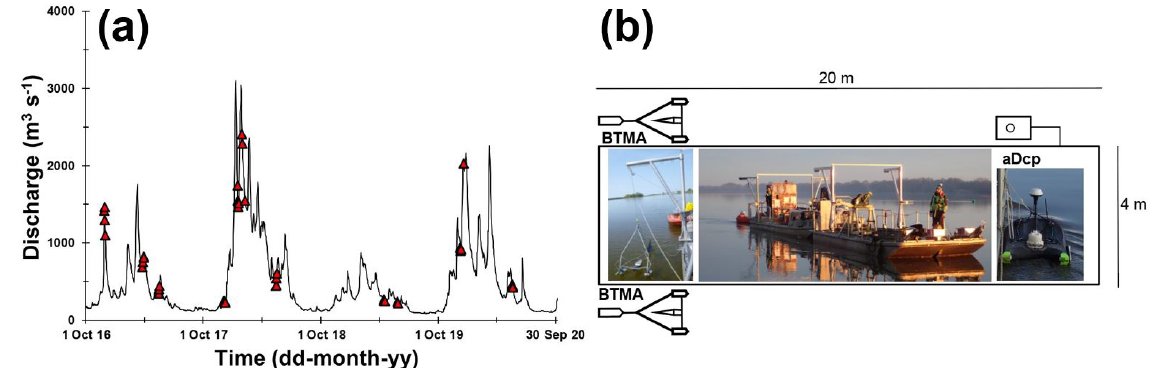
Figure 2. (a) Distribution of bedload sampling surveys along the hydrograph of Saumur gauging station located about 30km upstream from the study site. (b) Scheme of the main boat and disposition of monitoring facilities. Bedload transport meter Arnheim (BTMA) samplers; acoustic Doppler current profiler